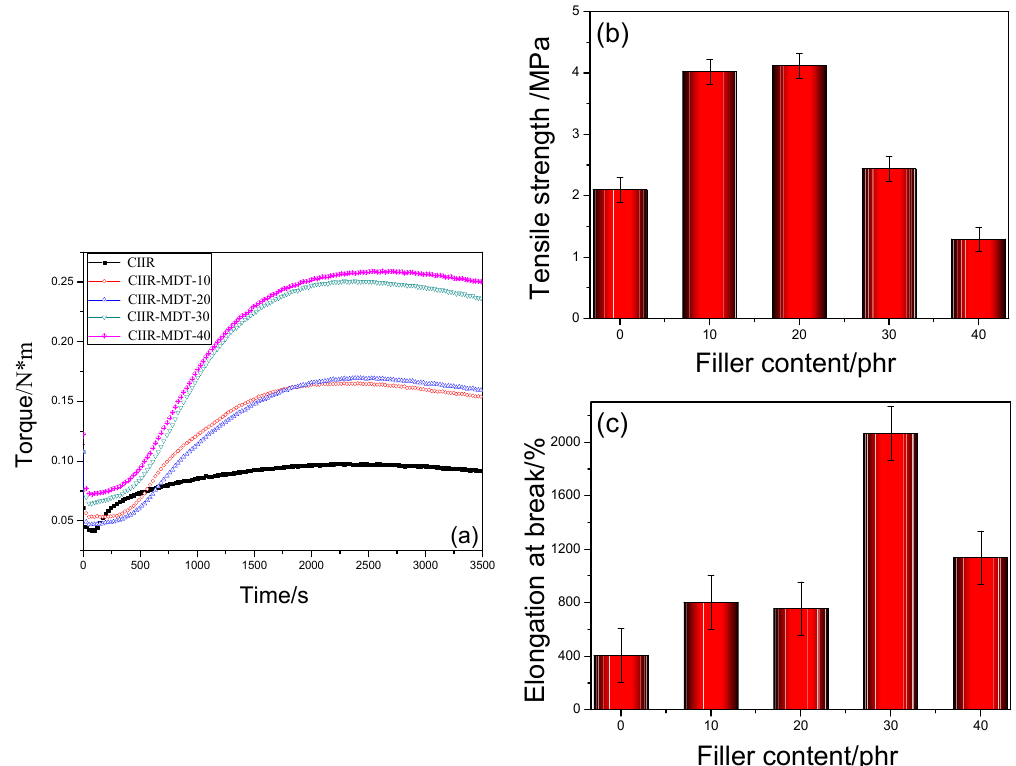
Figure 4. Cure curves ( a ); tensile strength ( b ); and elongation at break ( c ) of different CIIR composites.